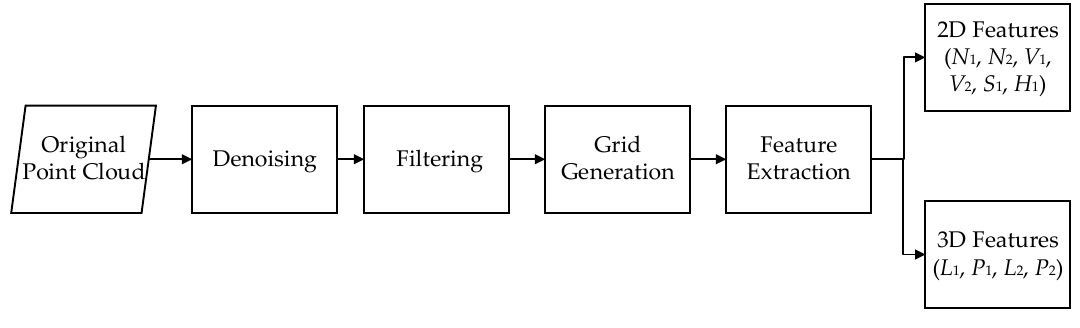
Figure 1. The workflow of feature extraction.